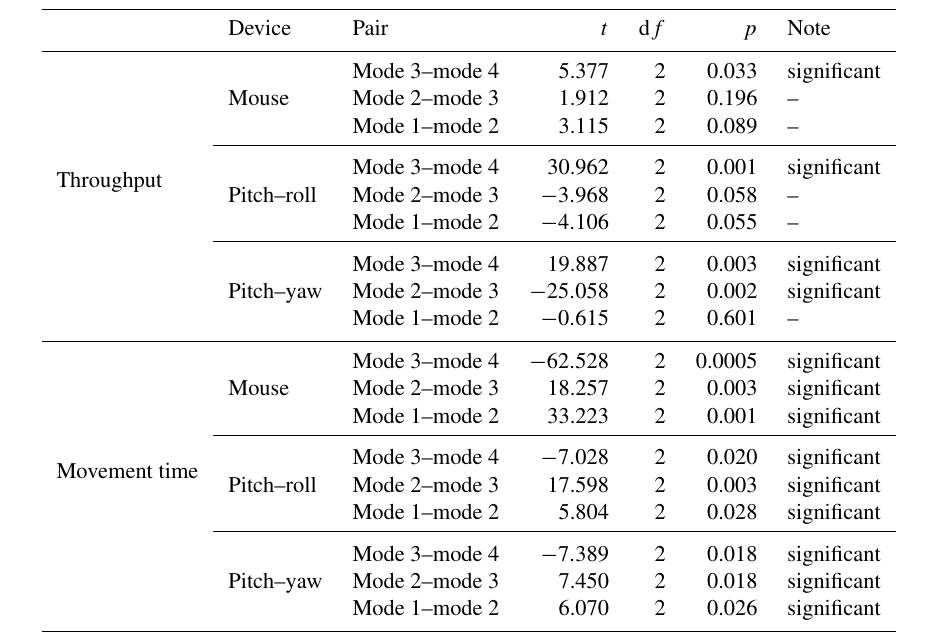
Table 4. The result of comparison of means (paired samples test).